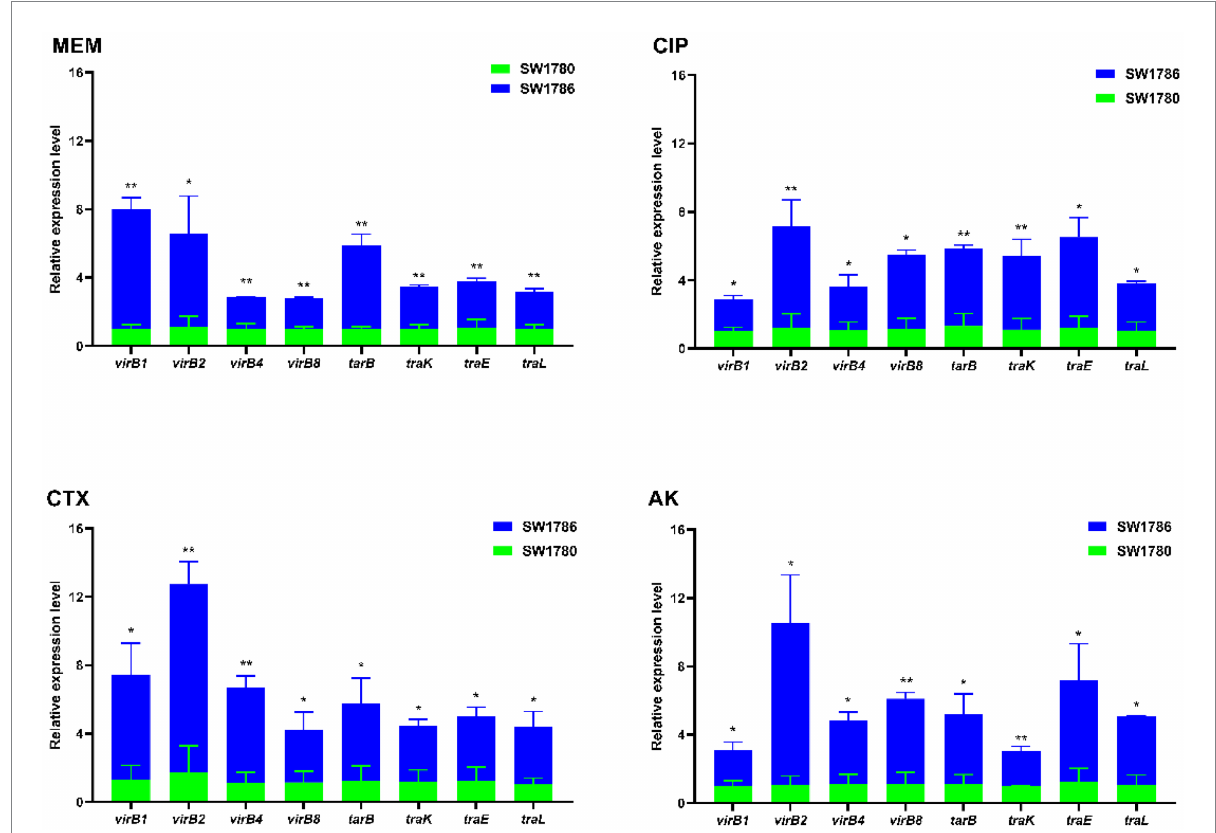
FIGURE 5 Transcript levels of T4SS and conjugation genes after treatment with sub-MIC antibiotics compared to untreated controls. The error bar shows the standard deviation. The stars indicate statistical significance at different levels: * P < 0.05, ** P < 0.01. SW1786 refers to strain SW1780 after 6-h exposure to different